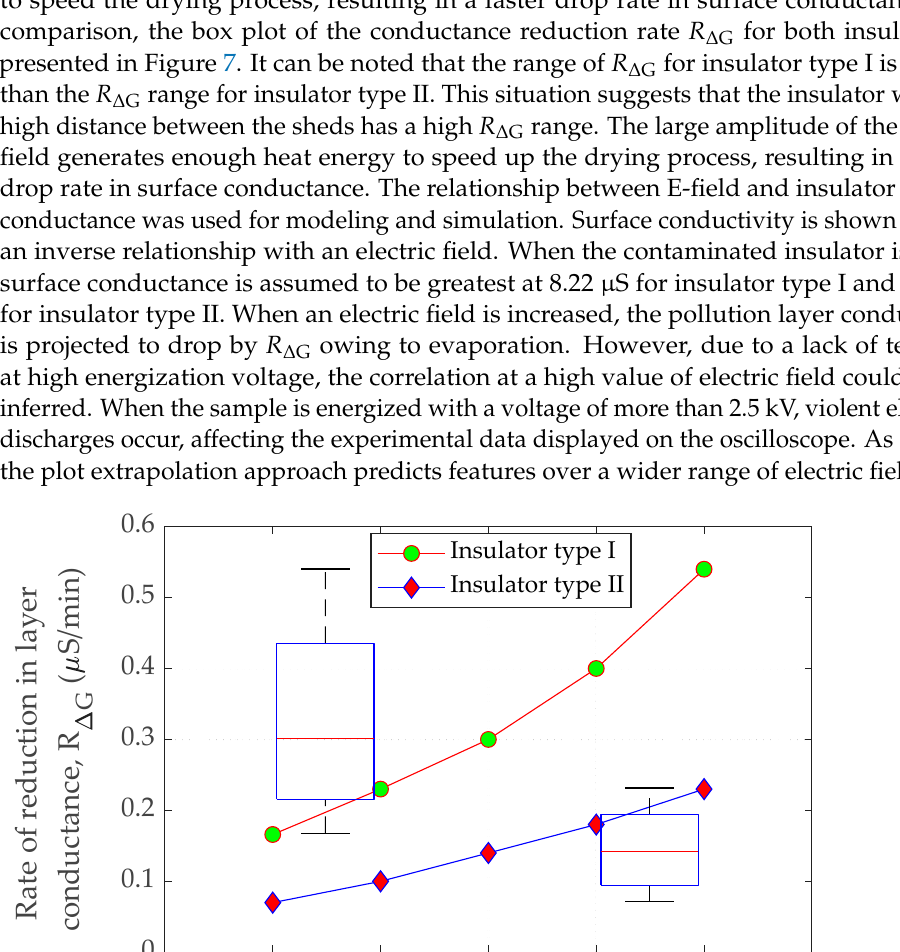
Figure 8. Relationship between the conductance and electric field for insulator type I.